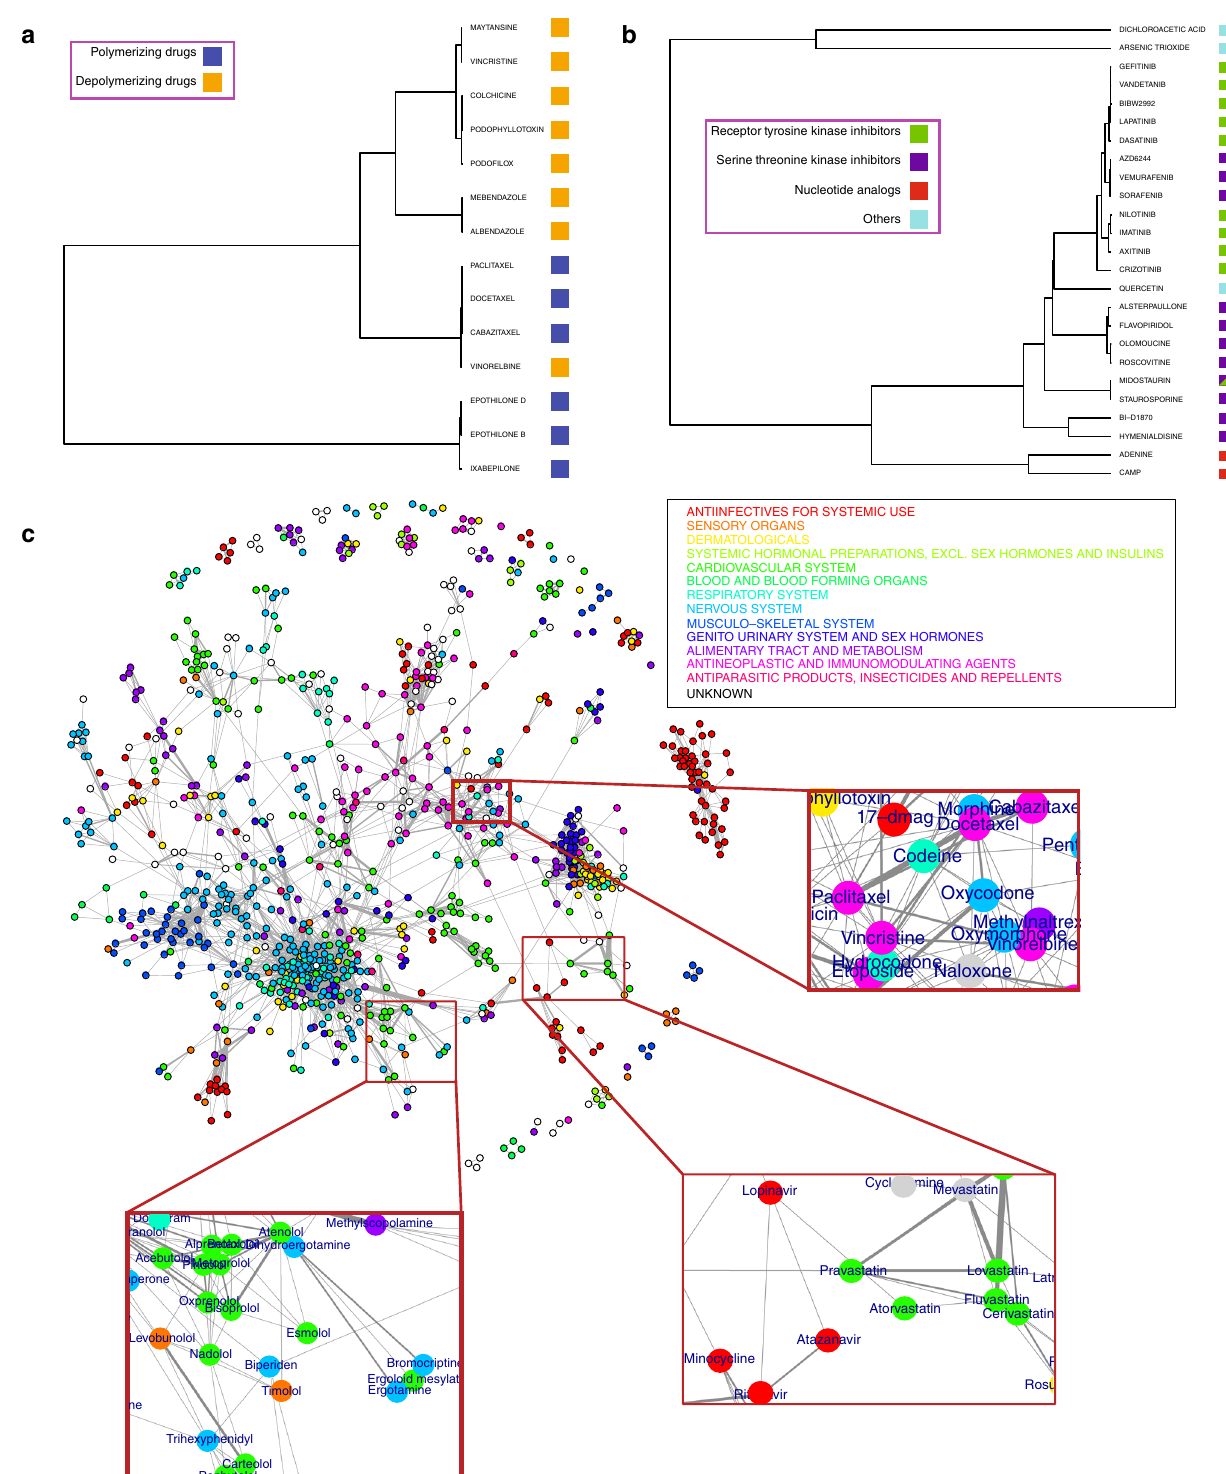
Fig. 6 BANDIT can predict speci fi c mechanisms of action and connections between drug classes. a Hierarchical clustering of drugs known to target microtubules and b drugs known to target protein kinases. c Network of drugs based on shared target interactions. Drugs are colored based on their most prevalent ATC code. Three speci fi c clusters corresponding to beta-blockers and Parkinson ’ s medications, anti-retrovirals and statins, and opioids and antimicrotubule drugs are